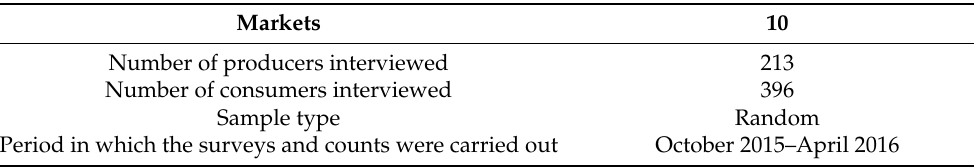
Table 2. Technical data of the research